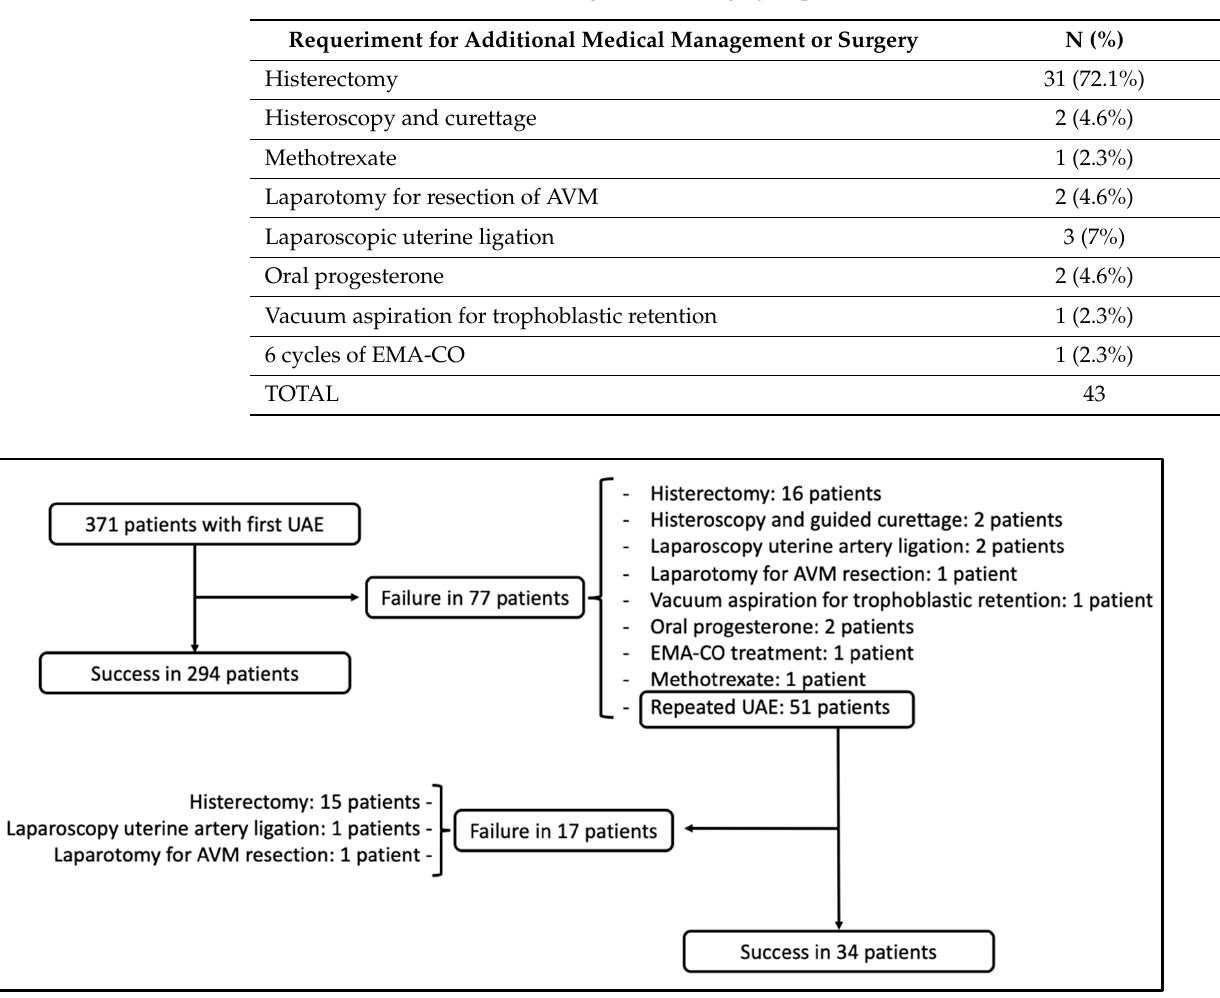
Table 4. Additional medical management or surgery required in the studies included.